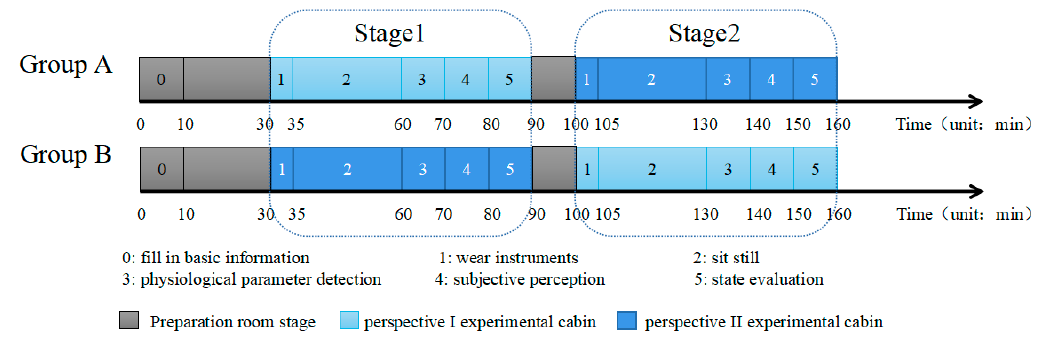
Figure 5. Experimental flow diagram.